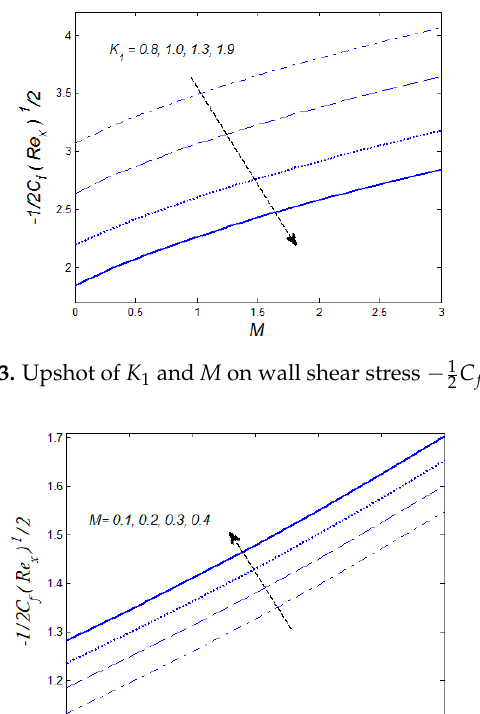
− 1/2 1 Re C . 2 f x C f Re 1/2 x . − 1/2 1 Re 2 C . 2 f x